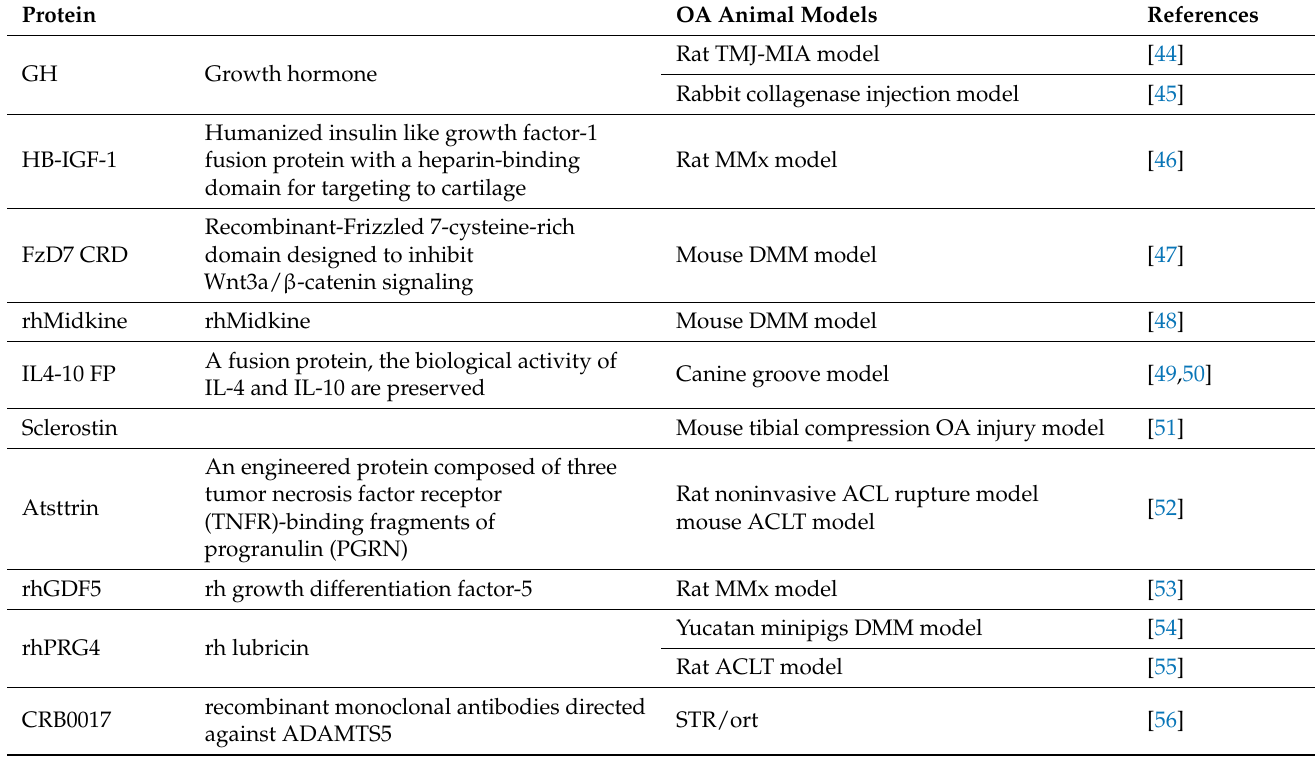
Table 2. Protein therapeutics candidates in OA animal models with reported